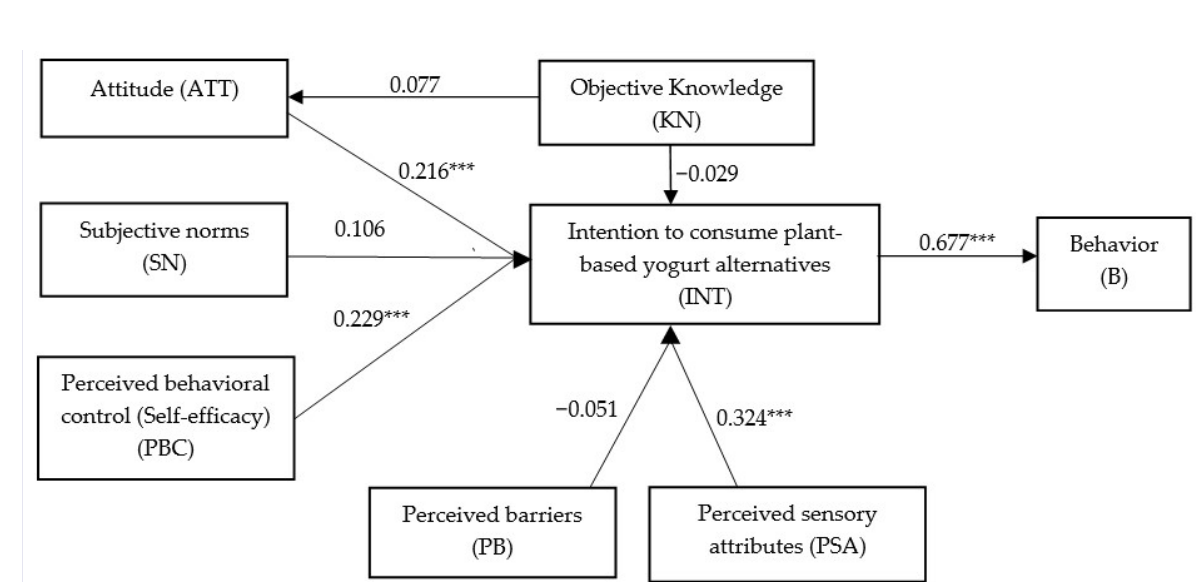
Figure 2. Structural relation between constructs (N = 265). Note: *** significant effect at p <